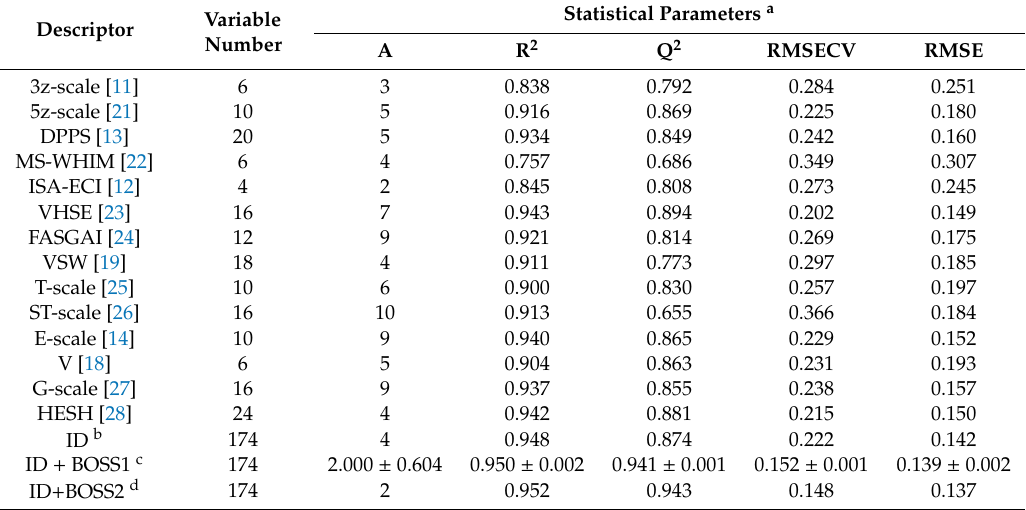
Table 2. Statistical parameters of QSAR models for dipeptides using a single set of amino acid descriptor and comparison with models built by integrated descriptor sets.